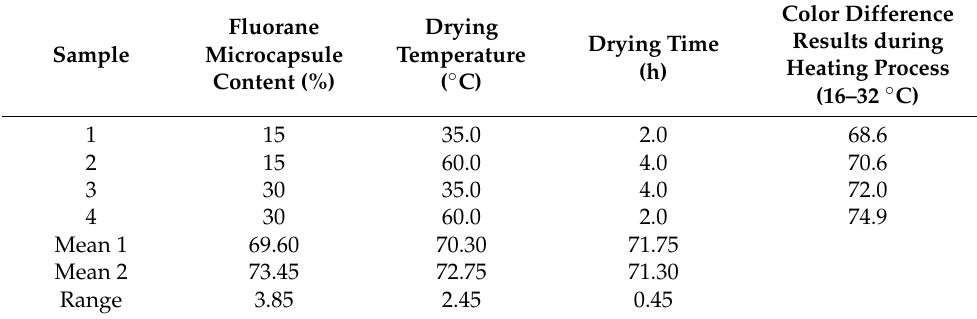
Table 4. Range analysis of the orthogonal test.